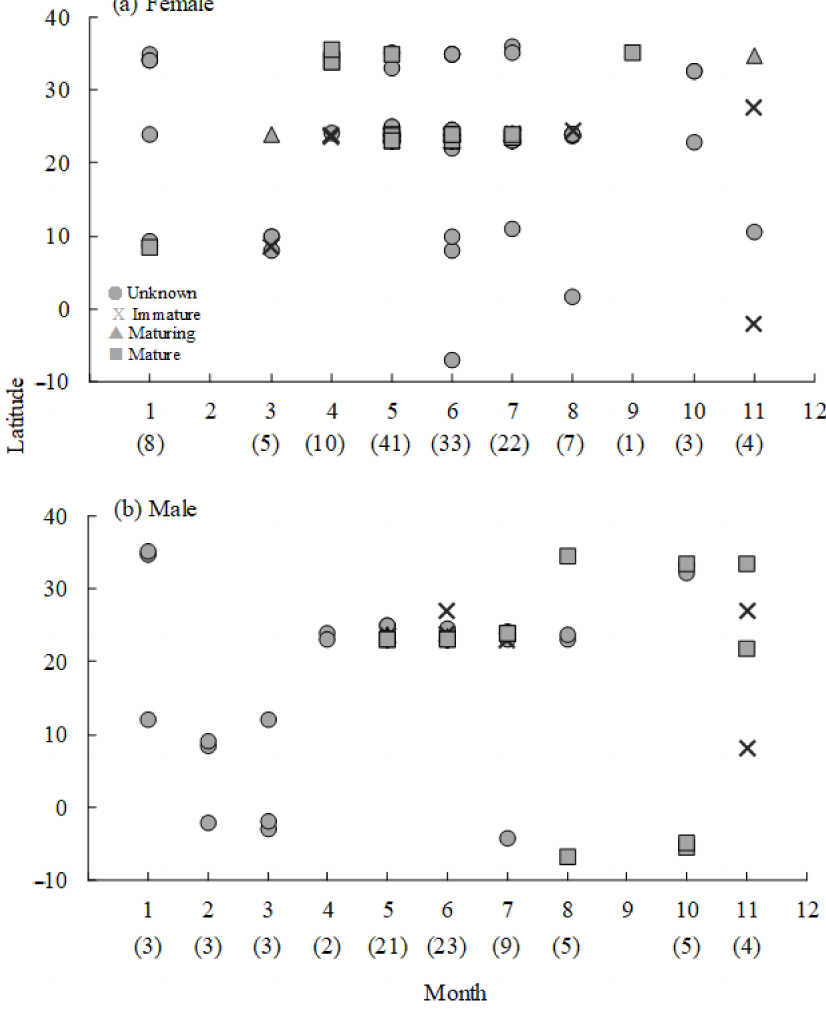
Figure 6. The monthly latitudinal occurrence in the Pacific Ocean of M. pelagios for ( a ) females and ( b ) males, number in the parentheses brackets was individual